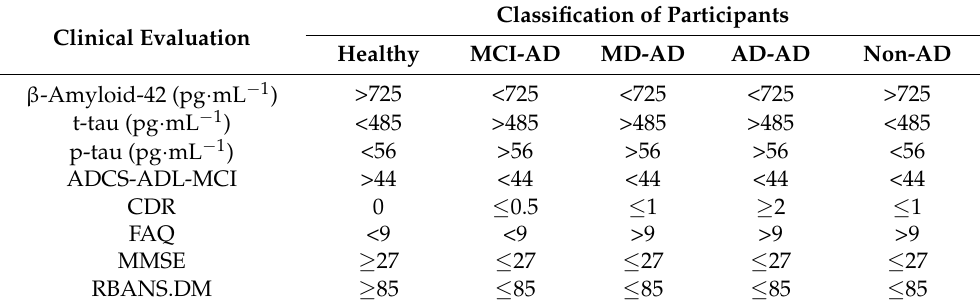
Table 1. Participants’ classification criteria, attending to CSF biomarkers and neuropsychological